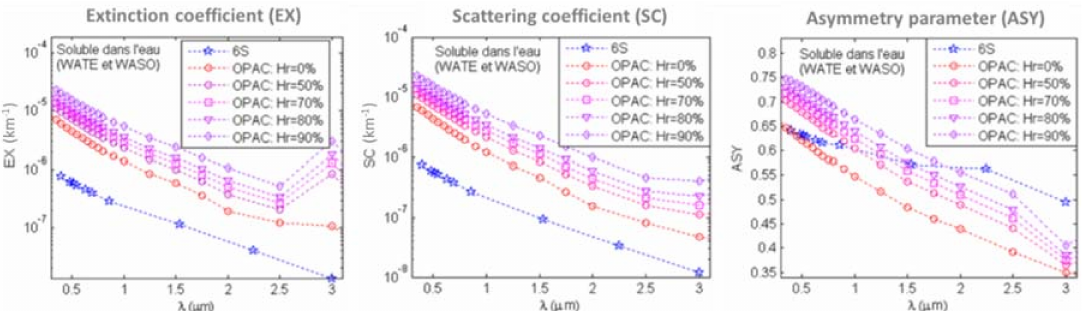
Figure 3. Comparison between aerosol properties extinction coefficient (EX), scattering coefficient (SC), and asymmetry parameter (ASY) of the Optical Properties of Aerosols and Clouds (OPAC) and 6S